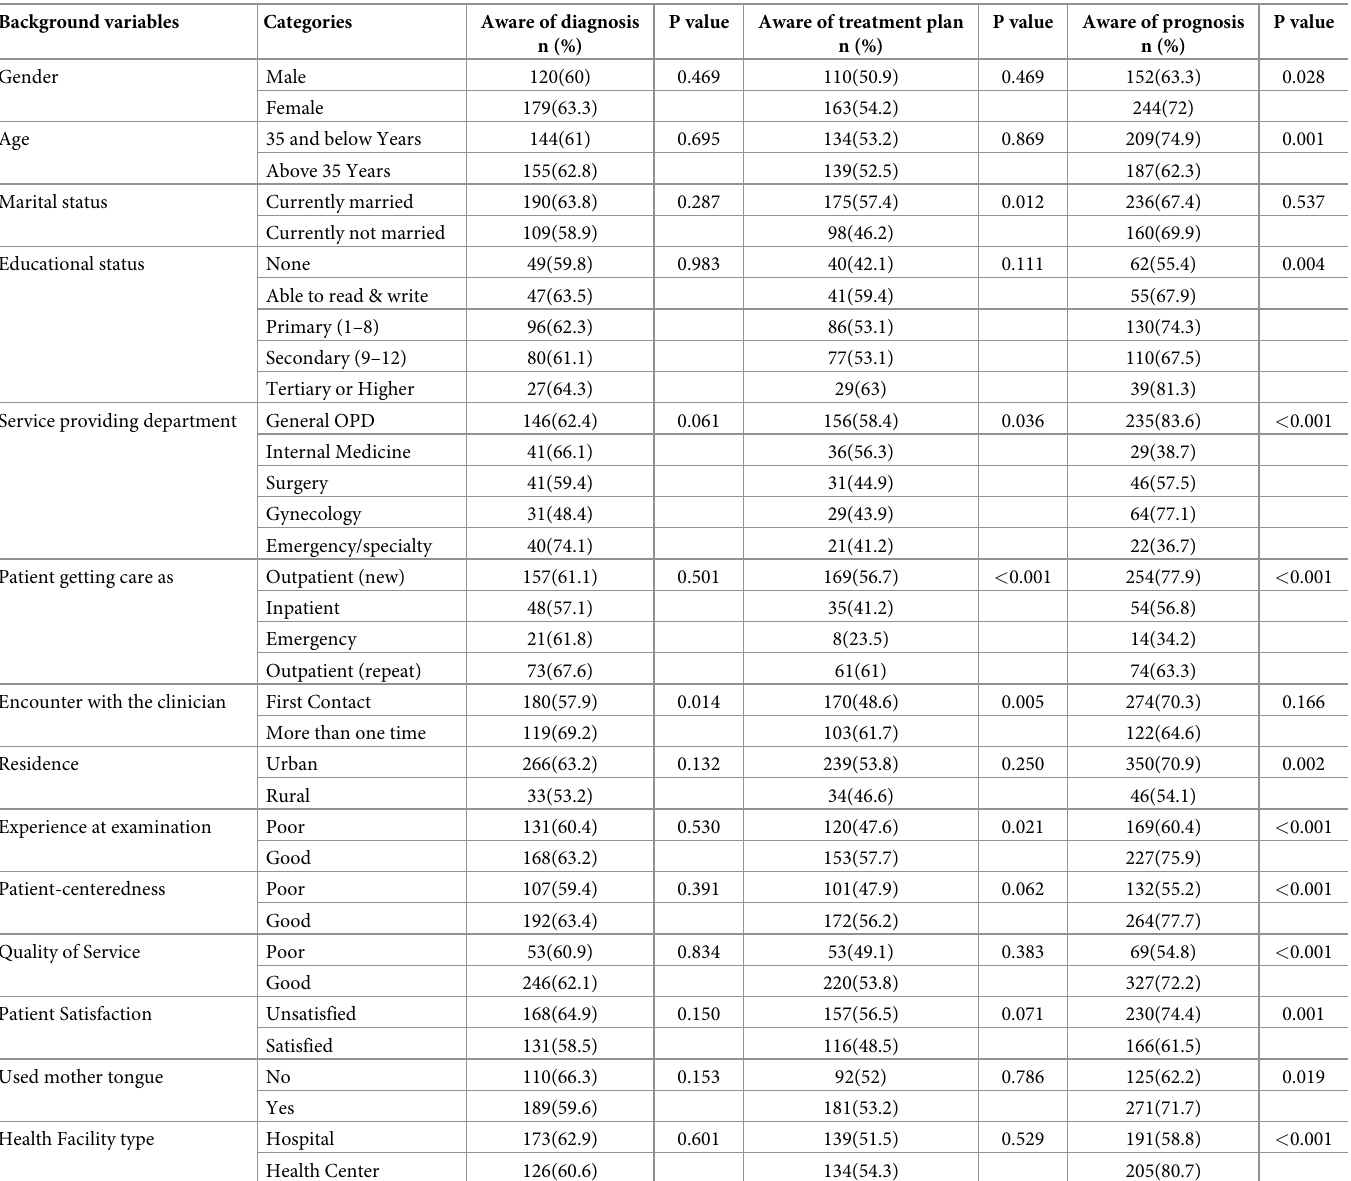
Table 2. Awareness of diagnosis, treatment plan and